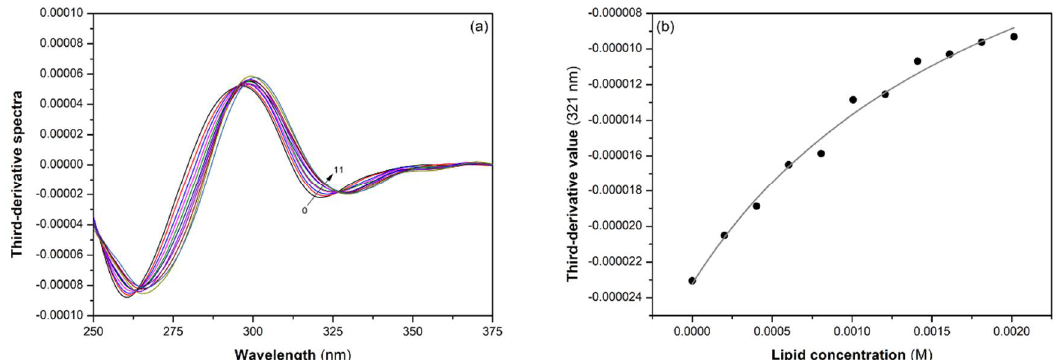
Figure 2. ( a ) Third-derivative spectra of DIC with increasing concentrations of POPC:CHOL (80:20) LUVS from 0 (0) to 2 mM (11) at 37 °C and pH 7.4; ( b ) Third-derivative values collected at 321 nm as a function of total lipid concentration. The gray line is the best fit for Equation (1).